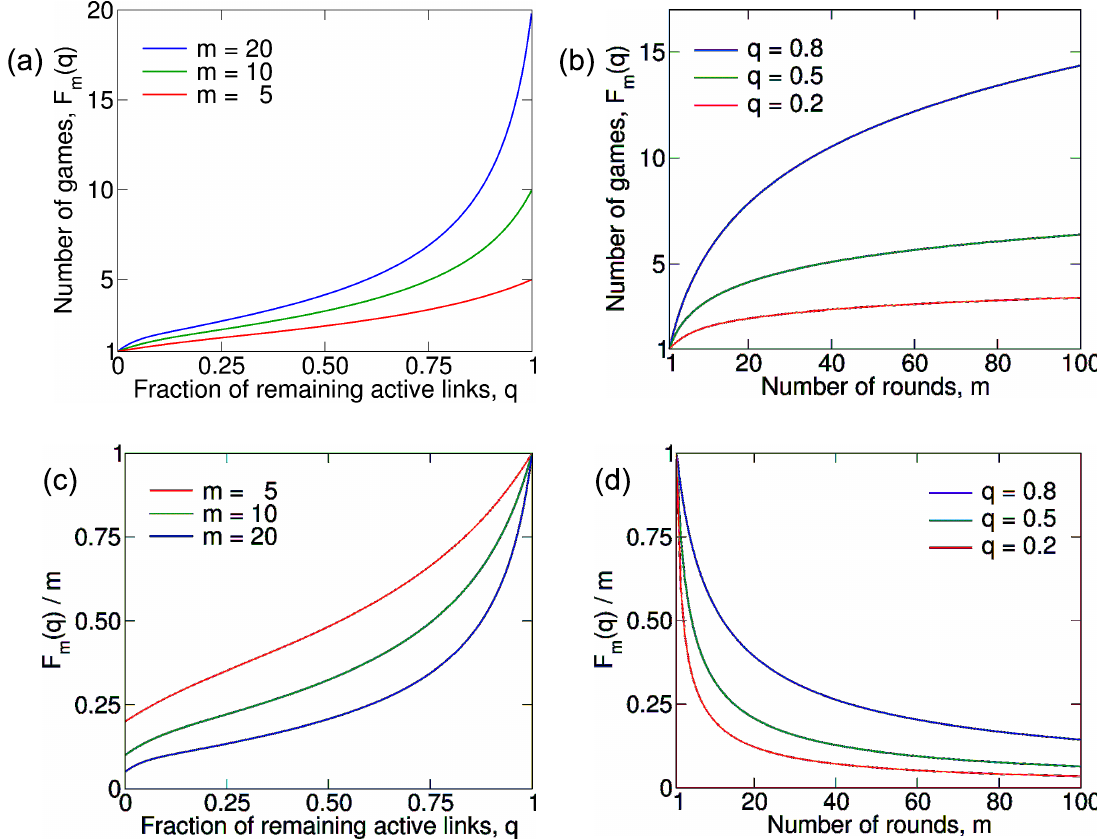
Figure 3. Average number of games that the defector plays. ( a ) Expected number of ( q ) , against the probability, q , to maintain each link when m = 5 , 10 , exploitations, F m ( q ) against the number of rounds, m , when q = 0 . 2 , 0 . 5 , and 20 (bottom to top); ( b ) F m and 0 . 8 (bottom to top); ( c ) Expected number of exploitations normalized by the number of ( q ) /m , against the probability, q , to maintain each link when m = 5 , 10 , and 20 rounds, F m ( q ) /m against the number of rounds, m , when q = 0 . 2 , 0 . 5 , and 0 . 8 (top to bottom); ( d ) F m (bottom to